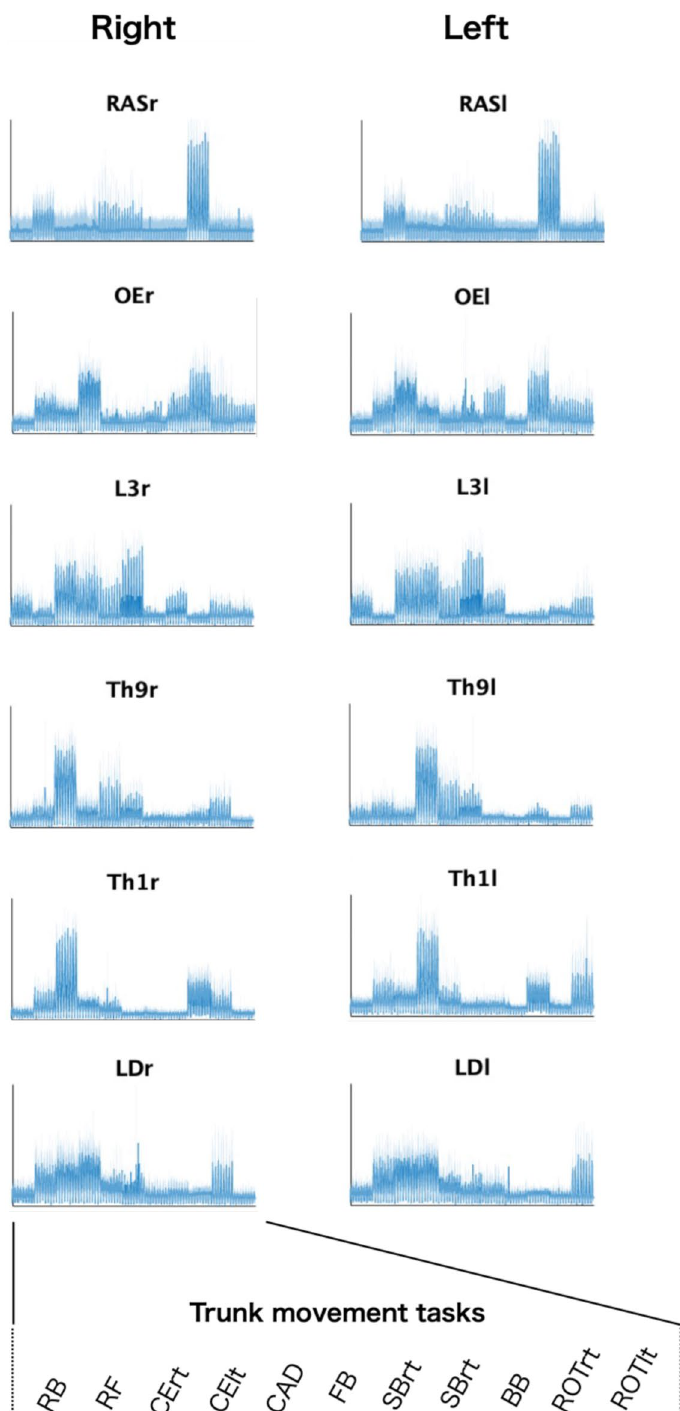
Figure 3. Muscle activation patterns of 1 l trunk movement tasks. The concatenated EMG envelope of 1 l trunk stability and movement tasks is shown. The mean of the EMG envelopes for 16 participants is plotted as a line and the standard deviation as a shading around it. The amplitude is normalized to the maximum value for each muscle over all tasks and standardized to have a unit variance to equally weight the EMG activity across all muscles before each synergy extraction